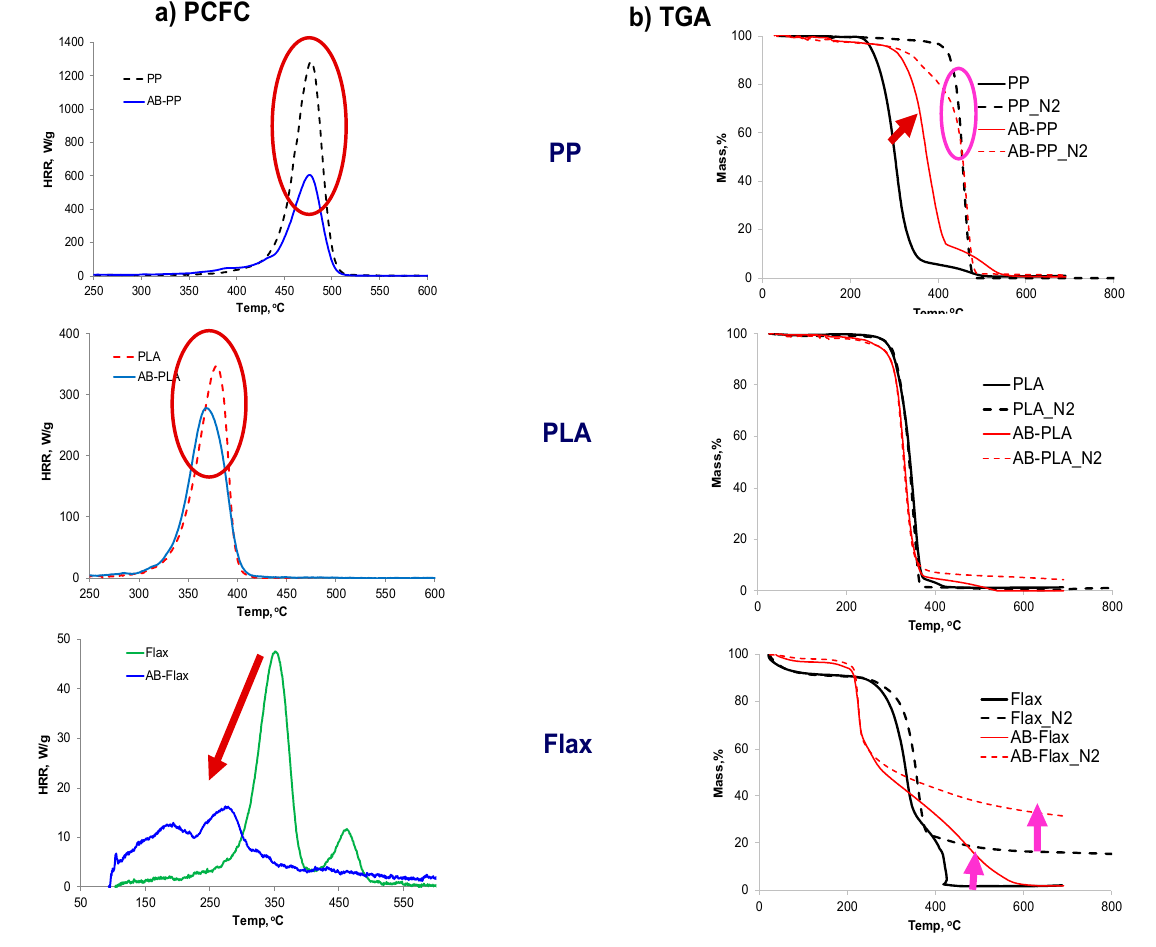
Figure 6. ( a ) PCFC and ( b ) TGA curves (in air and nitrogen) of ammonium bromide (AB) treated PP, PLA, flax, flax/PP, and flax/PLA.